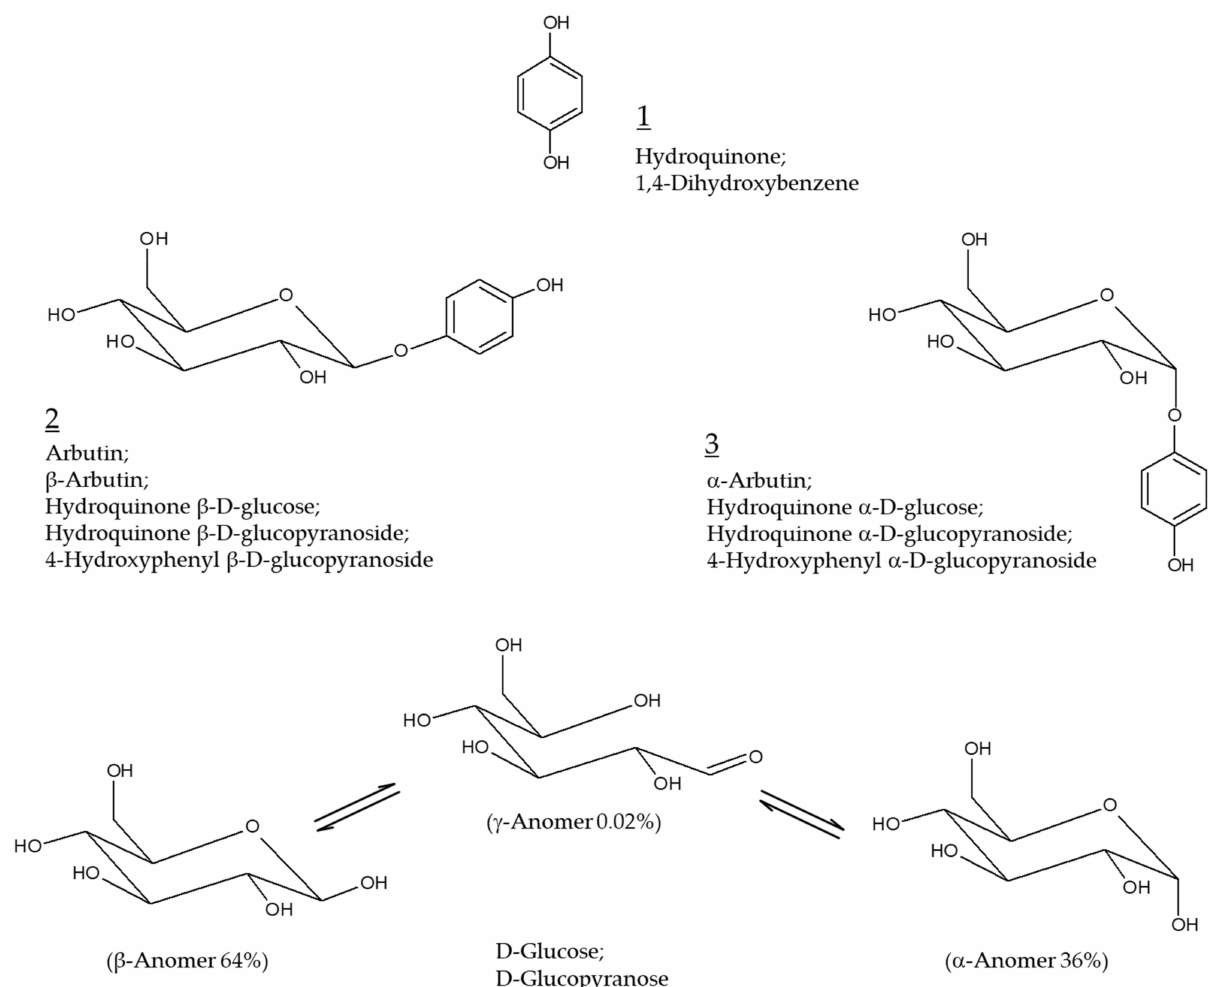
Figure 1. Chemical structures of hydroquinone, arbutin ( β -arbutin), and α -arbutin. Anomeric structures of D-glucose are also shown for comparative